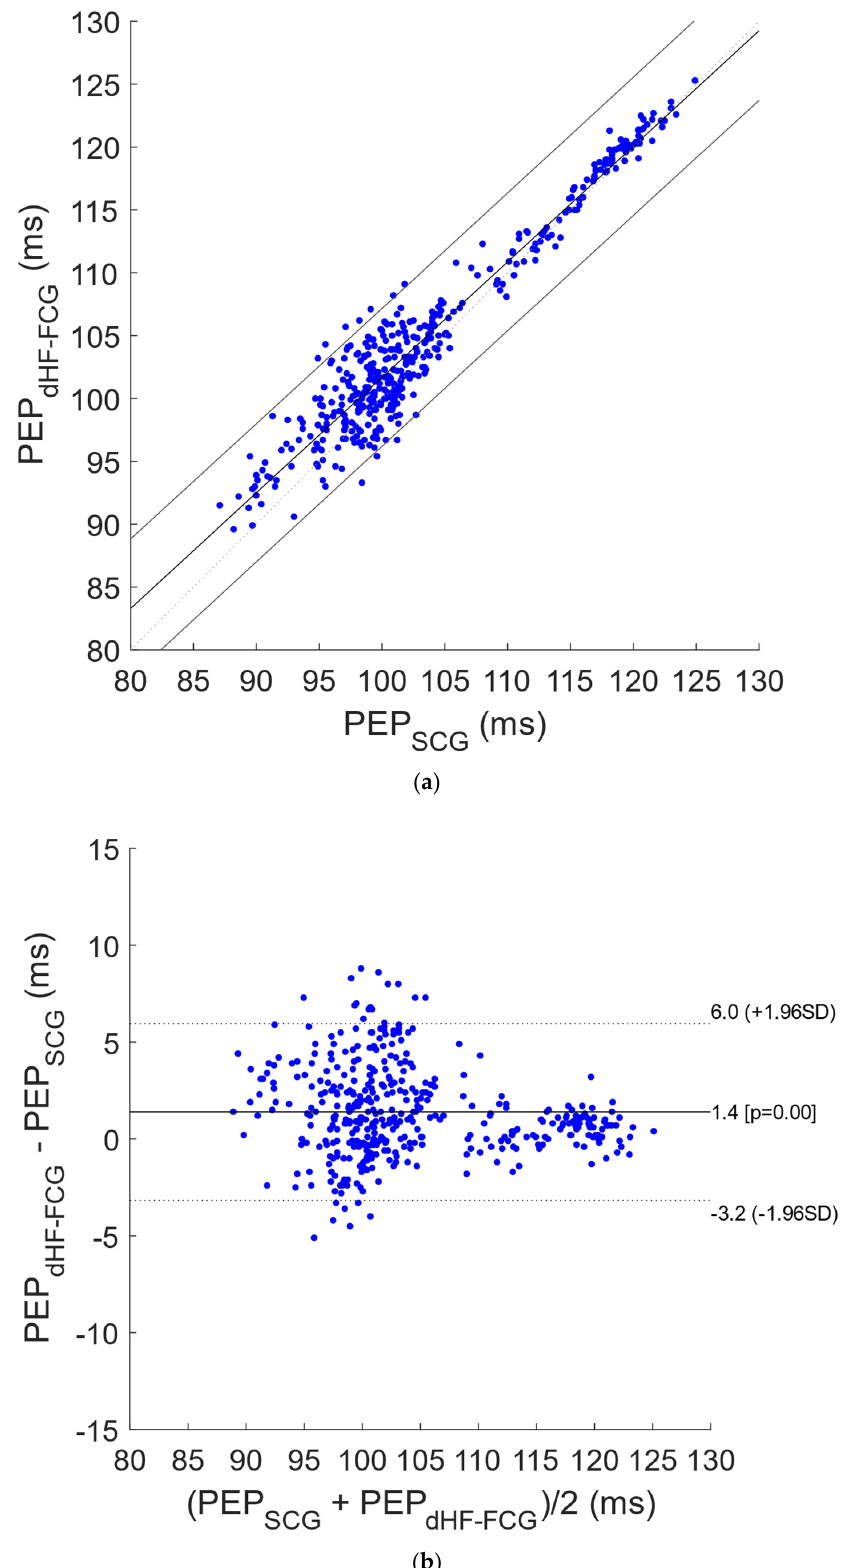
Figure 6. Statistical analyses on PEP estimates related to signals acquired during quiet breathing: ( a ) results of regression and correlation analyses; ( b ) results of Bland–Altman analysis.